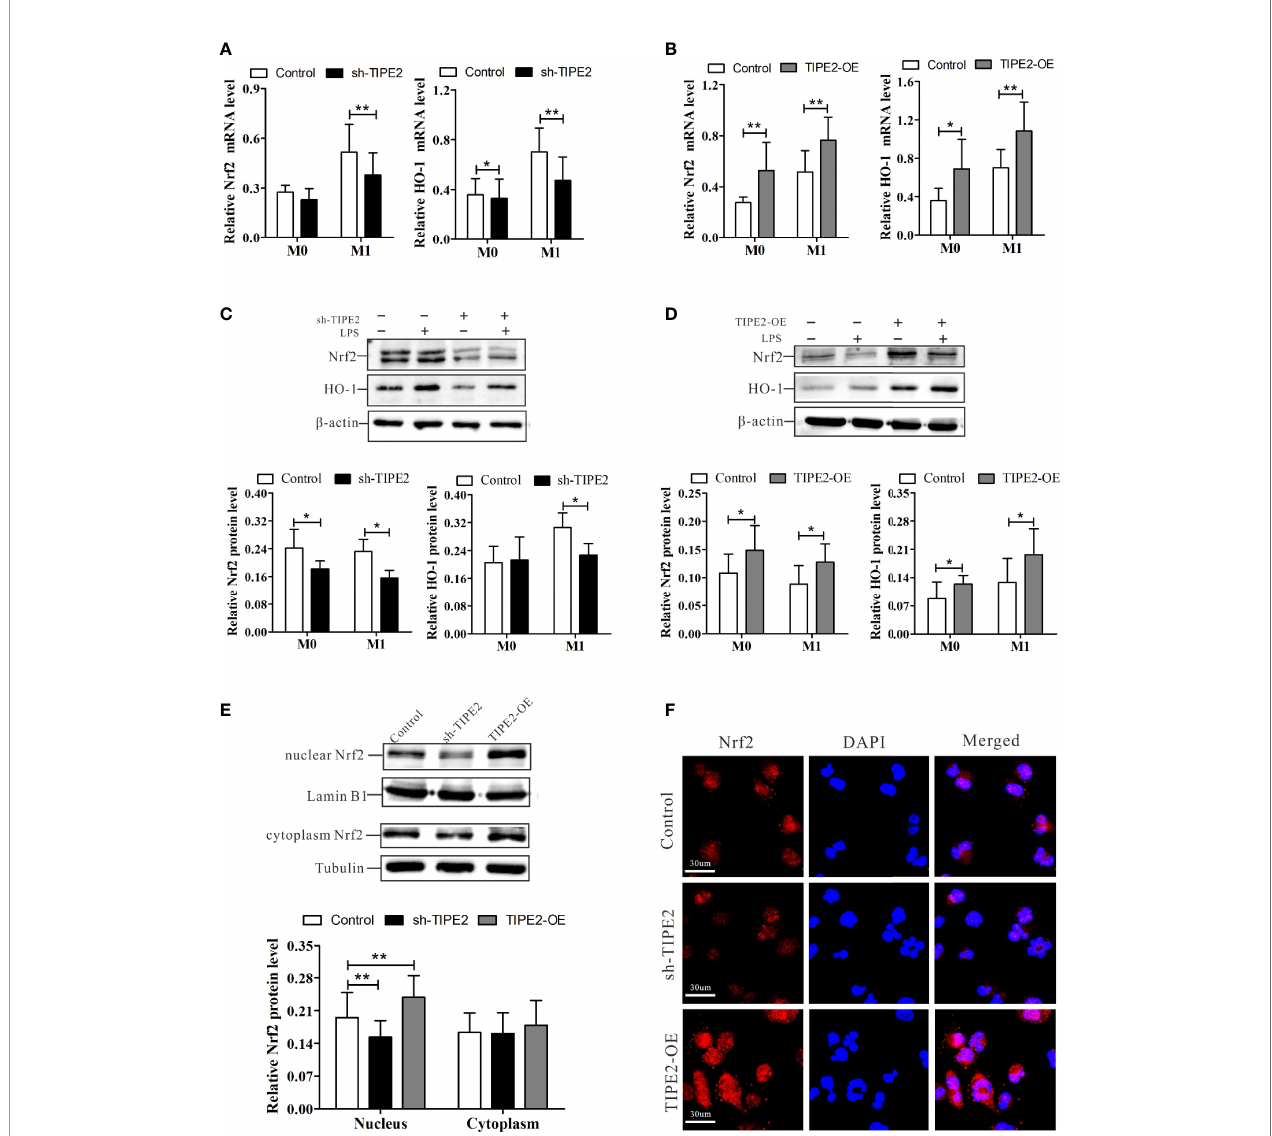
FIGURE 6 | TIPE2 promotes Nrf2/HO-1 signaling pathway activation. (A, B) Expression of Nrf2 and HO-1 in THP-1 monocytes by RT-qPCR following treatment with PMA (20 ng/ml) for 48 h and LPS (1 µg/ml) for 24 h. (C, D) Nrf2 and HO-1 protein levels in THP-1 monocytes were detected by western blotting analysis following treatment with PMA (20 ng/ml) for 48 h and LPS (1 µg/ml) for 24 h. (E) Expression of nuclear and cytoplasmic Nrf2 in M1 macrophages was detected by western blotting analysis. (F) Expression of Nrf2 in M1 macrophages was detected by immunocytochemistry analysis. Statistics were performed on pooled data from at least three independent experiments. Error bars represent the standard deviations of the means. A comparison of two groups was performed using Student ’ s t-test. Comparison of the means among three groups was performed using one-way ANOVA followed by post-hoc test (LSD or Tamhane ’ s T2). *P<0.05, **P<0.01. TIPE2, tumor necrosis factor a – induced protein 8 – like protein 2; Nrf2, nuclear factor erythroid 2 – related 2; HO-1, heme oxygenase-1; RT-qPCR, reverse transcription – quantitative polymerase chain reaction; shRNA, short hairpin RNA; TIPE2-OE, TIPE2 overexpression; LPS, lipopolysaccharide; PMA, phorbol-12-myristate-13-acetate; CTRL, control vector; ANOVA, analysis of variance; LSD, least signi fi cant